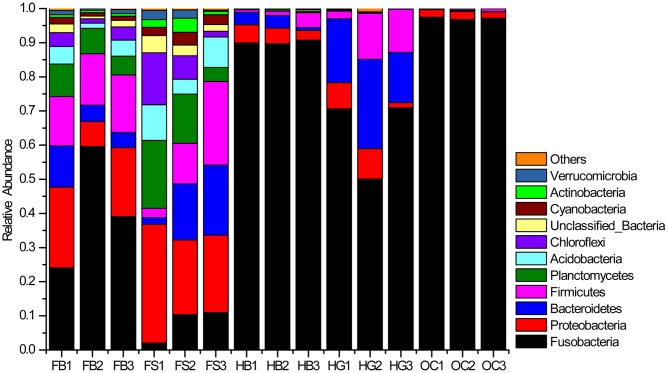
Bacterial composition of the different communities (relative read abundance of bacterial phyla within each community). Lanes FB1–FB3, FS1–FS3, HB1–HB3, HG1–HG3, and OC1–OC3 correspond to the three individuals of bighead carp, silver carp, blunt snout bream, grass carp, and crucian carp, respectively.